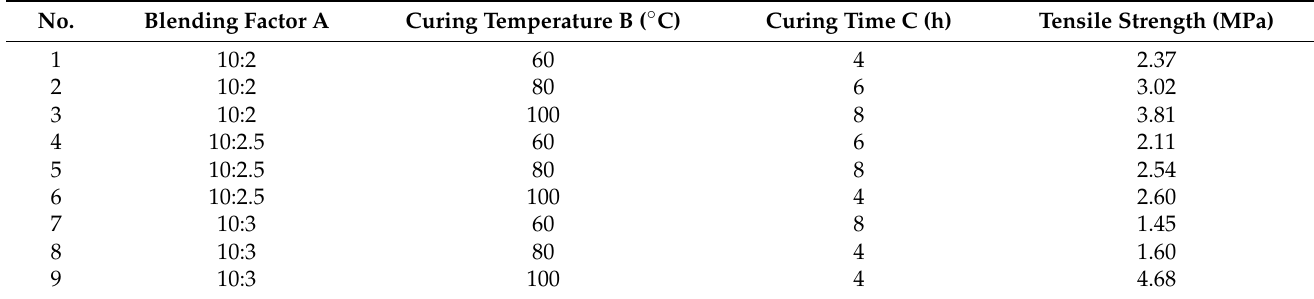
Table 3. Orthogonal test results for tensile strength and various factors of polyurethane adhesive.